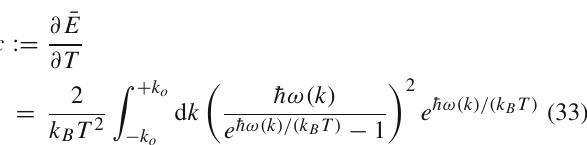
0 . 015 in Planck units (in blue) compared to the continuum case (in dashed